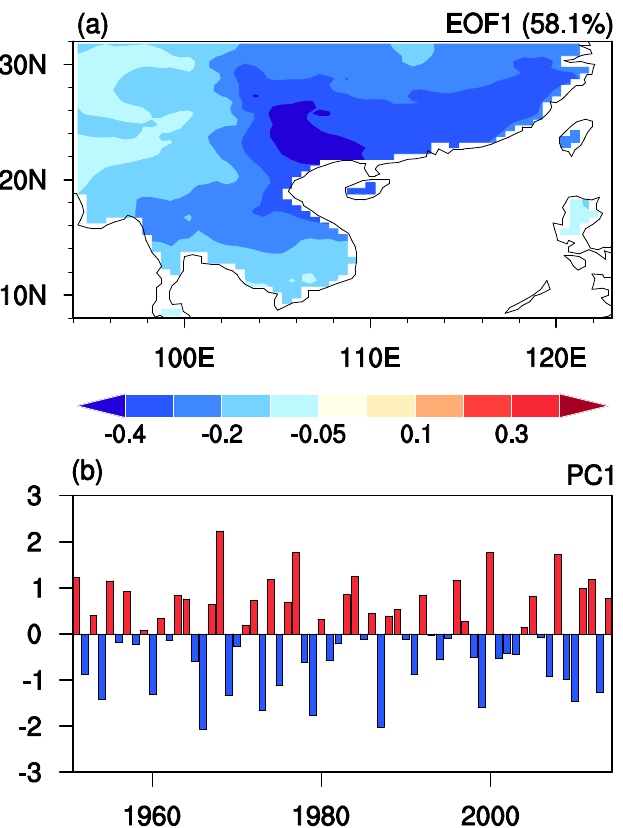
Figure 2. ( a ) The first EOF mode of interannual variation of boreal winter SAT over southeast Asia during 1951–2014. (b) The corresponding PC time series of the first EOF mode.